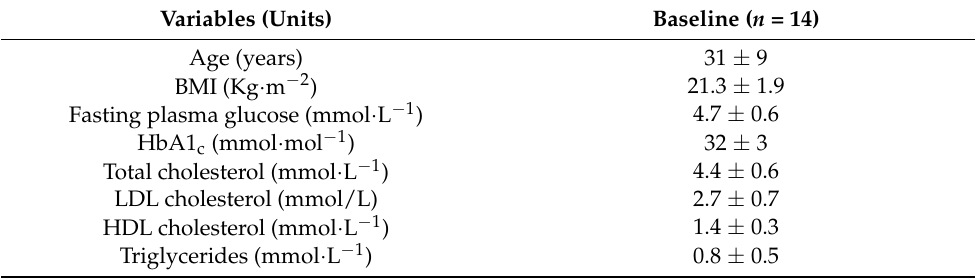
Table 1. Baseline clinical and biochemical characterization of the study population.